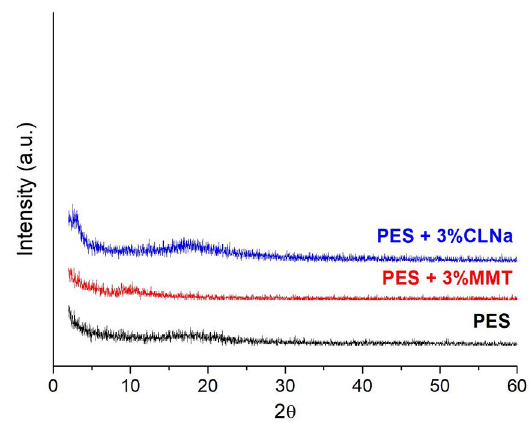
Figure 4 . XRD diffractions patterns of PES and PES membranes with 3% MMT and CLNa.